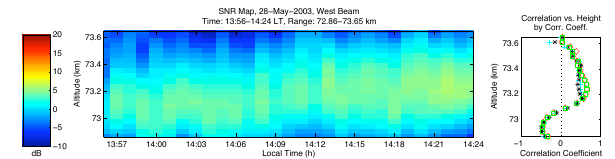
Fig. 7. Turbulent layer centered about 73.2 km on May 28 at 13:56 LT.